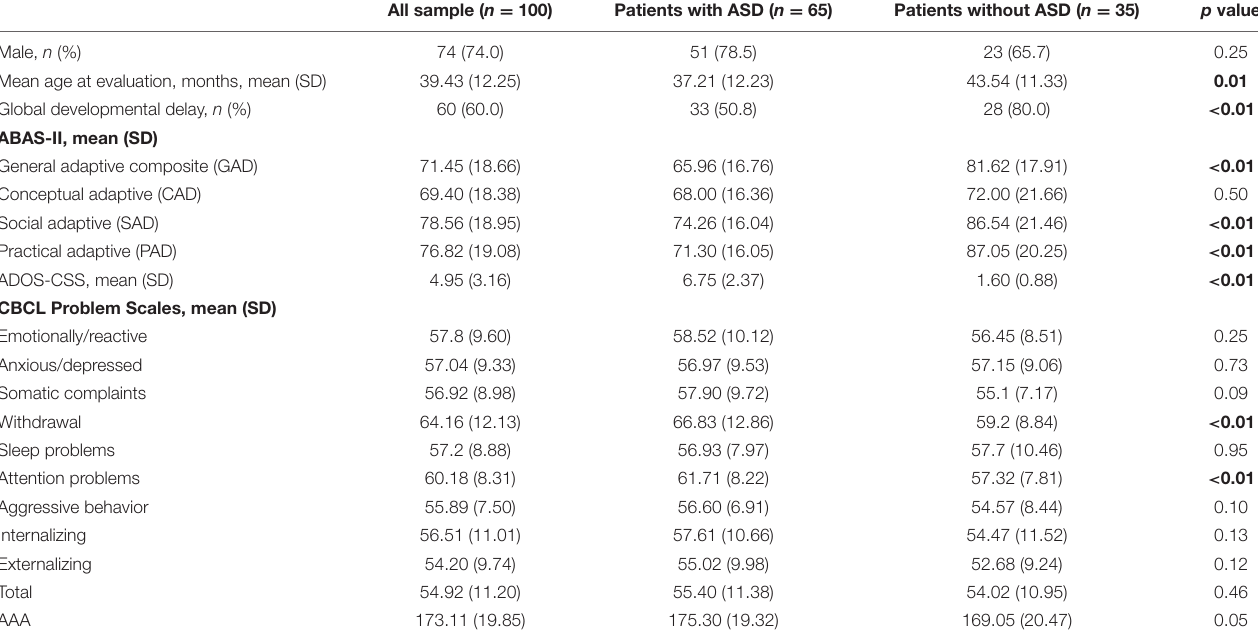
TABLE 1 | Demographics and clinical